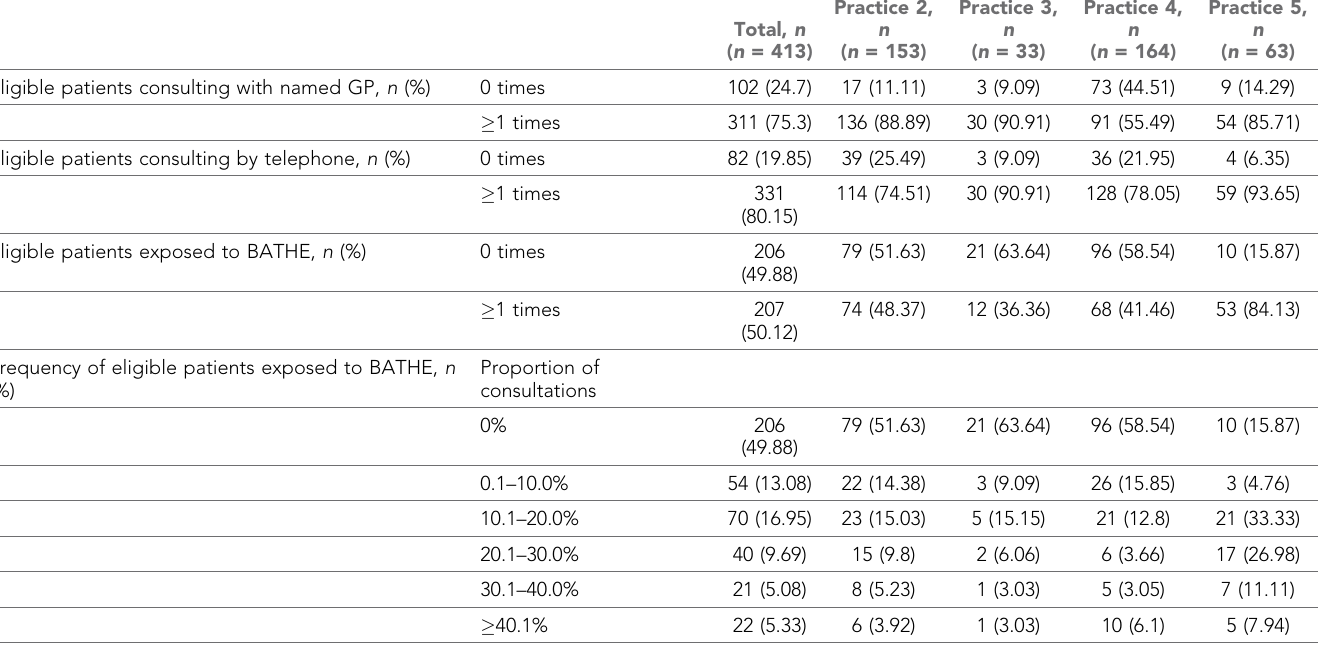
Table 3a Adherence to the intervention components